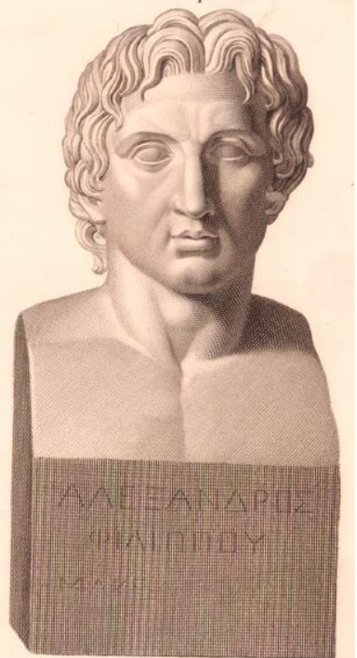
Figure 13. (Alexander of